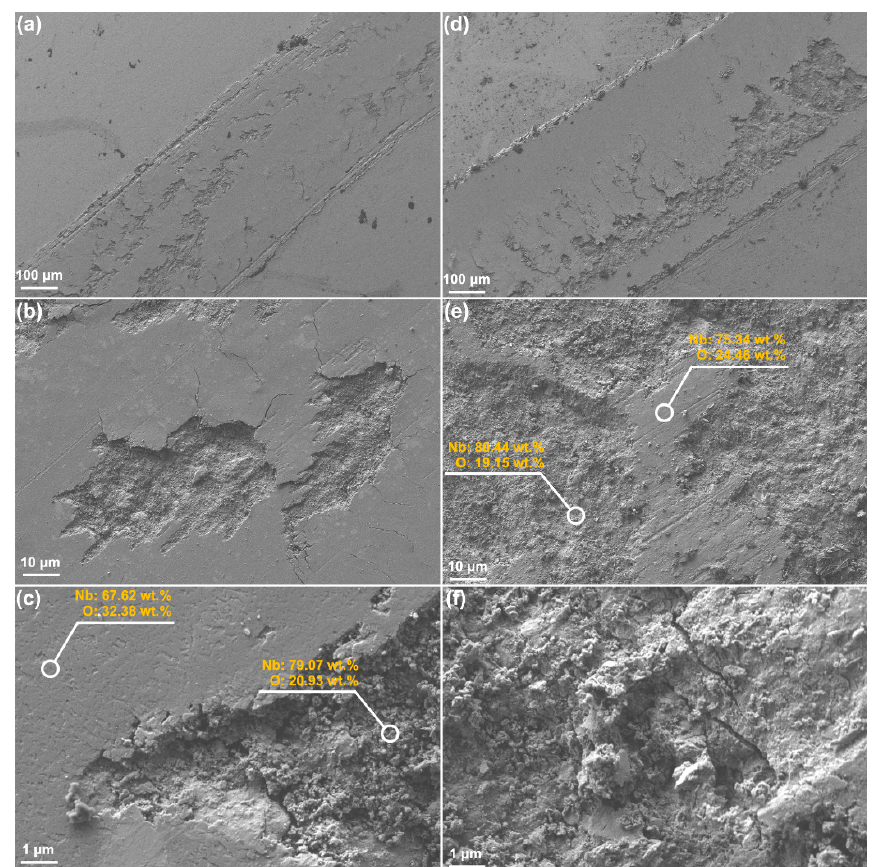
Figure 7. The SEM images of Nb after the potentiostatic tribocorrosion tests with different applied potentials: ( a – c ) 200 mV, ( d – f ) 400 mV; the EDS results were inserted in the images.